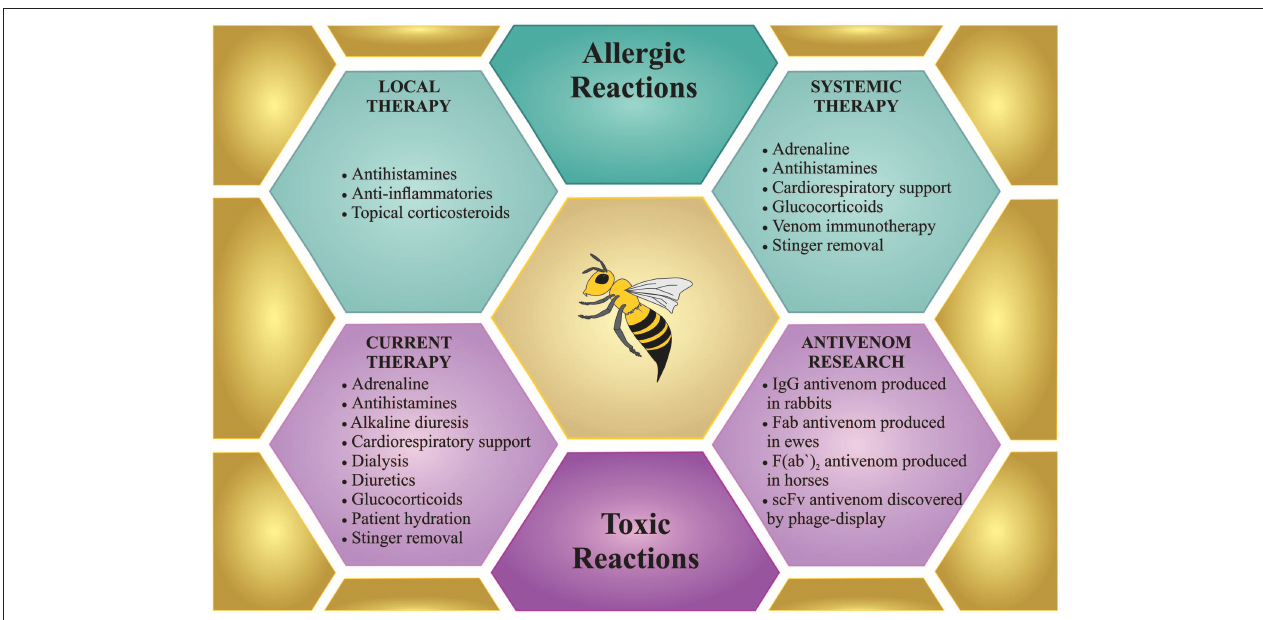
FIGURE 4 | Treatment for bee sting(s). Bees incidents can involve few stings, which can cause local reactions or anaphylactic shock, which request a treatment similar to any allergic reactions (in green). However, mass stinging events can prove life-threatening via the toxic action of the venom when injected in large amounts, which demands intensive treatment (in purple). Although specific treatment is not available so far, only few antivenom researchers are working on developing new therapies against bee